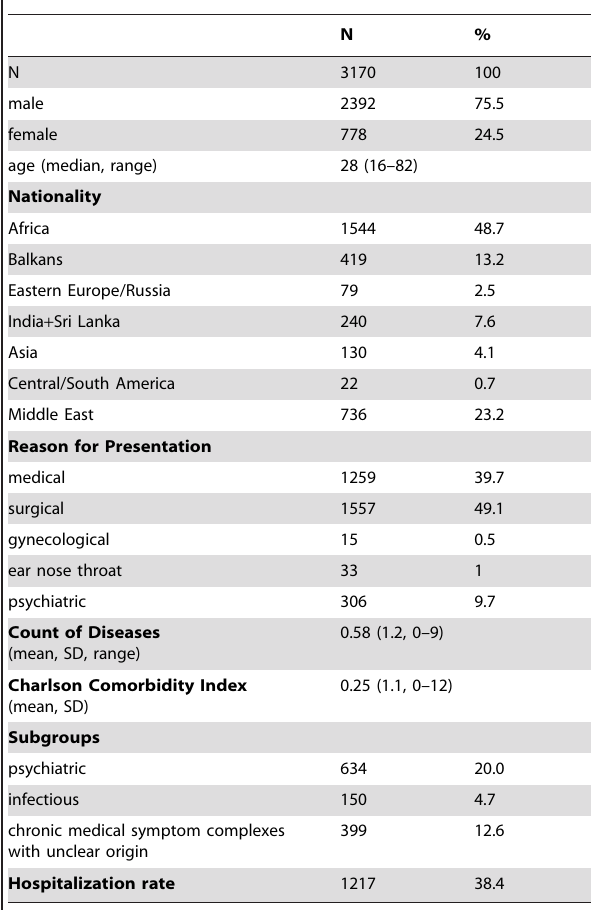
Table 2. Patient